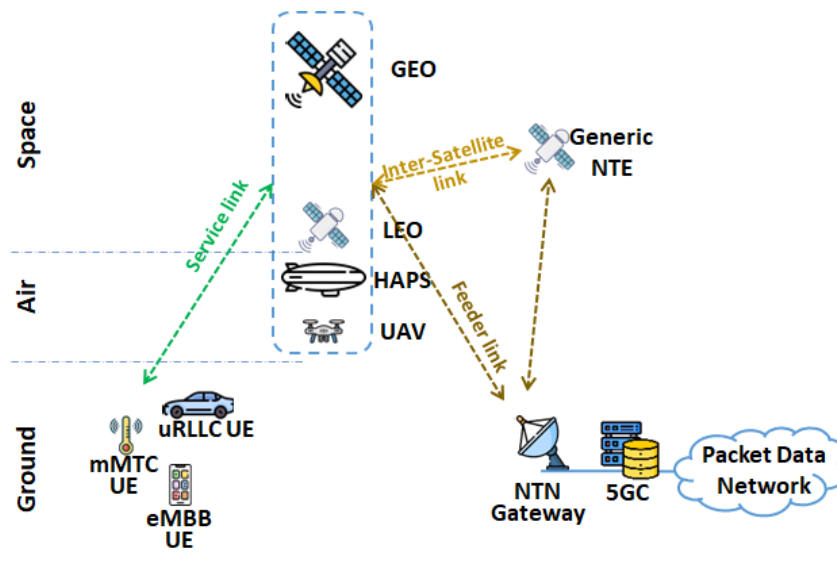
Figure 1. Reference architecture of the non-terrestrial